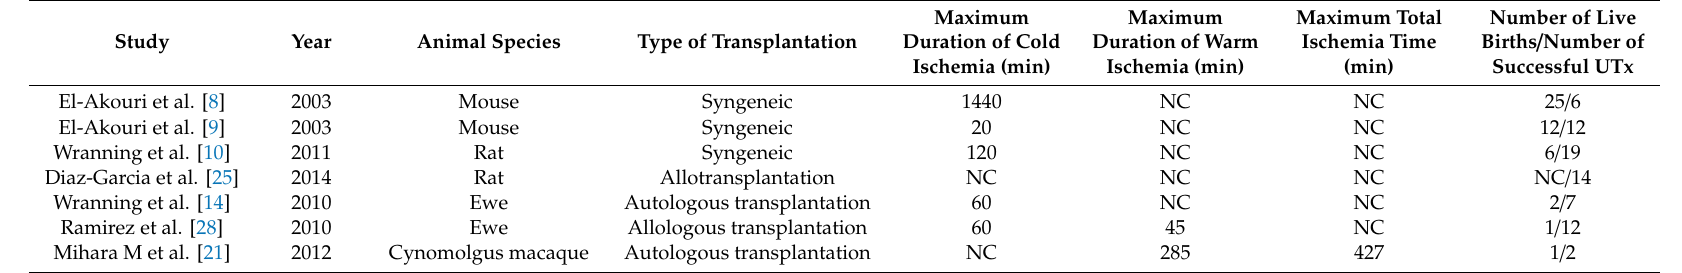
Table 1. Summary of the studies in which live births have been obtained after uterus transplantation (UTx) in